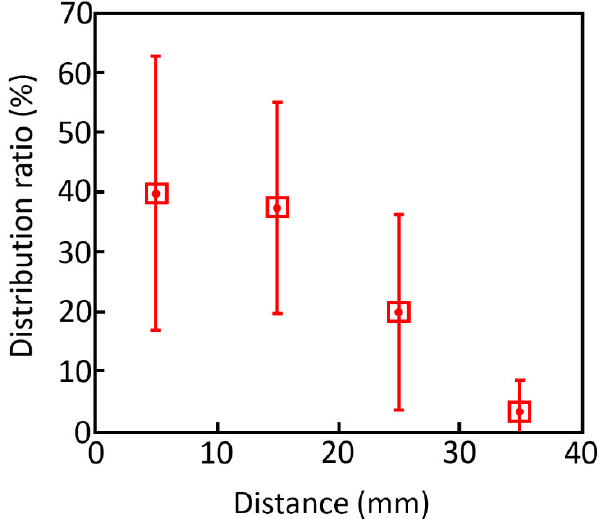
Figure 11. Distribution ratio of deployed microgrippers over distance from the targeted delivery point. Reproduced with permission from Ref. [10]. Copyright 2014. point. Reproduced with permission from Ref. [10]. Copyright